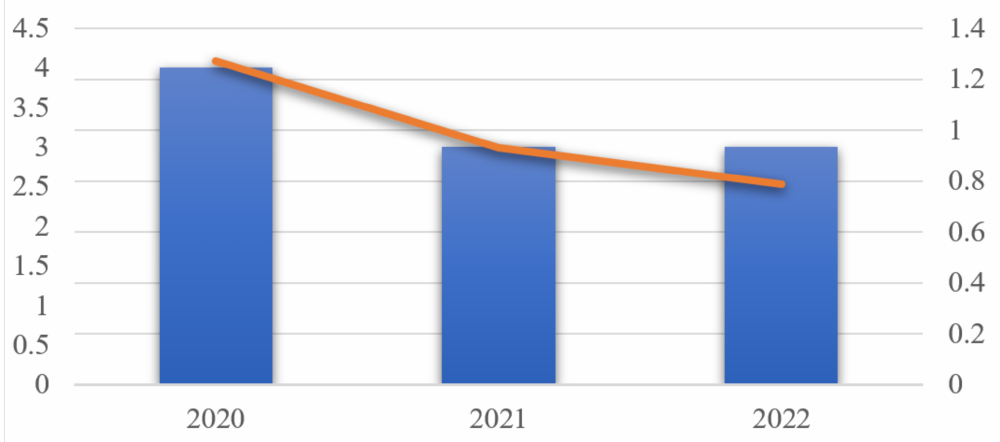
Figure 8. Range and standard deviation of PCR.